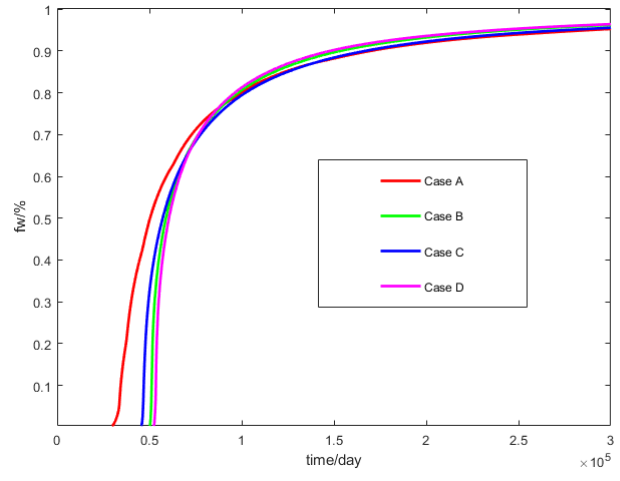
Figure 6. The changing process of water cut of the four